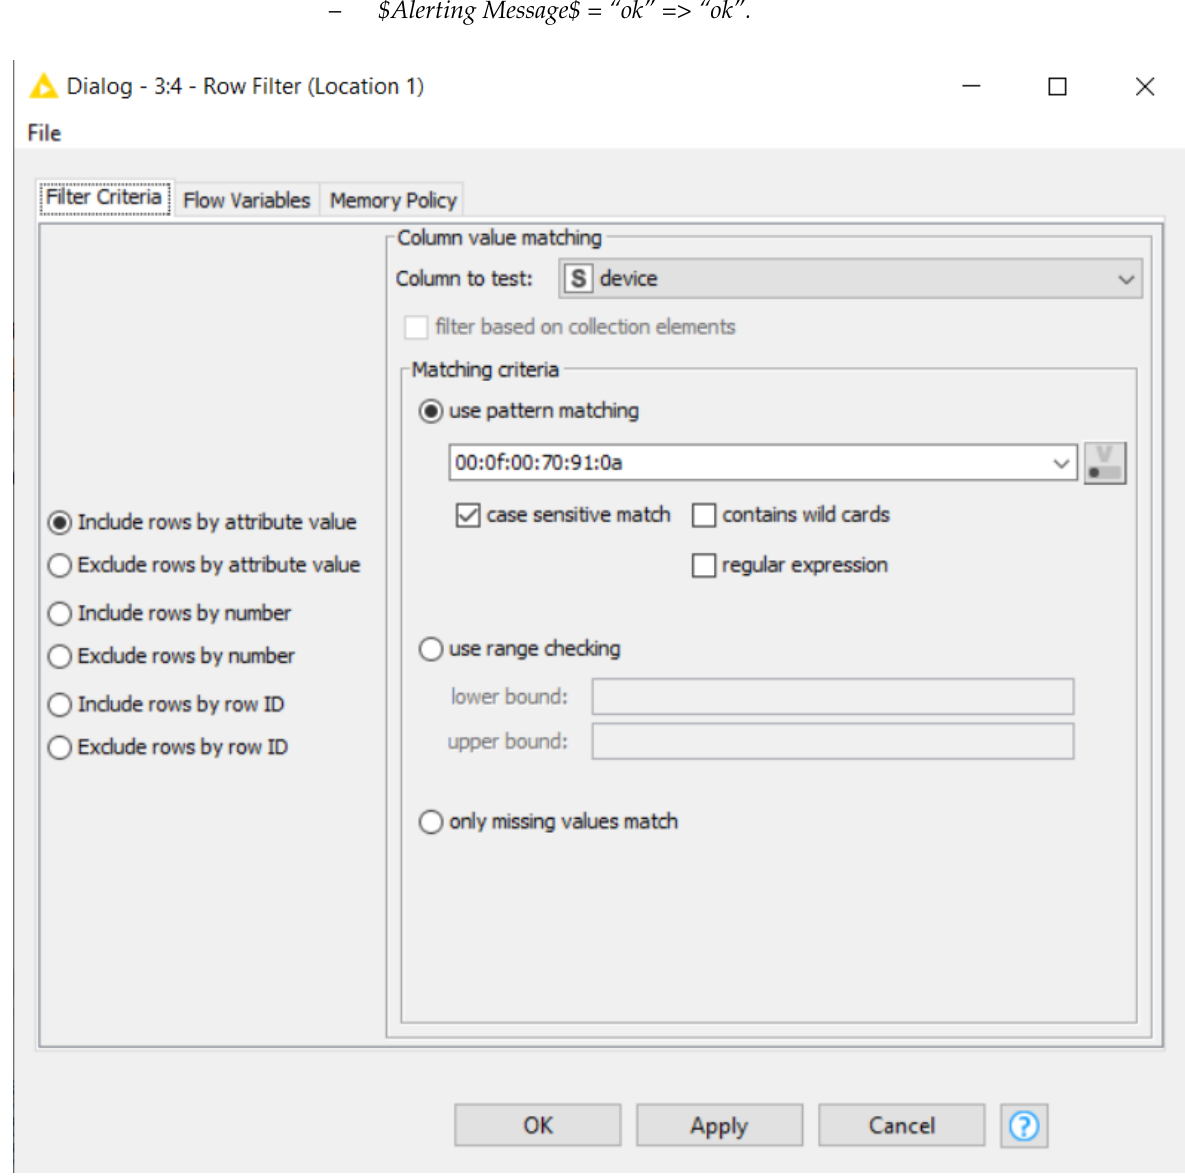
Figure A3. KNIME GUI selecting device of a location (“Row Filter” block). The ANN-MLP hyper-parameters adopted for the calculus are: 100 epochs (maximum number of iterations), 1 hidden layer, 10 hidden neurons per layer, smoke as labelled variable, 70% of the dataset for training process, 30% of the dataset for testing process, co and smoke as input nodes. The processed data refers to the location 1 (device 1). 405,184 records are processed for the prediction of the smoke variable. In Figure A4 is sketched the used ANN-MLP model according to the selected